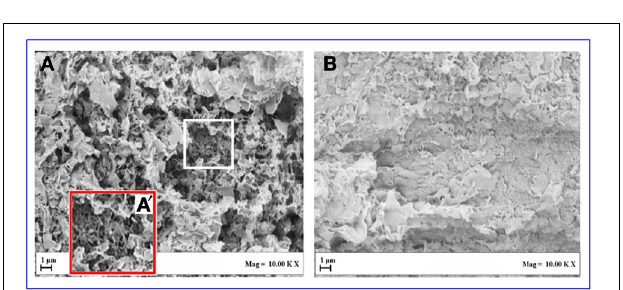
FIGURE 6 | Photographs of cylindrical monolithic (diameter of 7mm) s-PS/OMMT aerogels, with porosity P = 90%, as obtained by scCO 2 drying and exhibiting a 80/20 weight ratio: (A) with exfoliated clay; (B) with intercalated clay. The shown aerogels essentially present the same size and shape of the precursor gels.